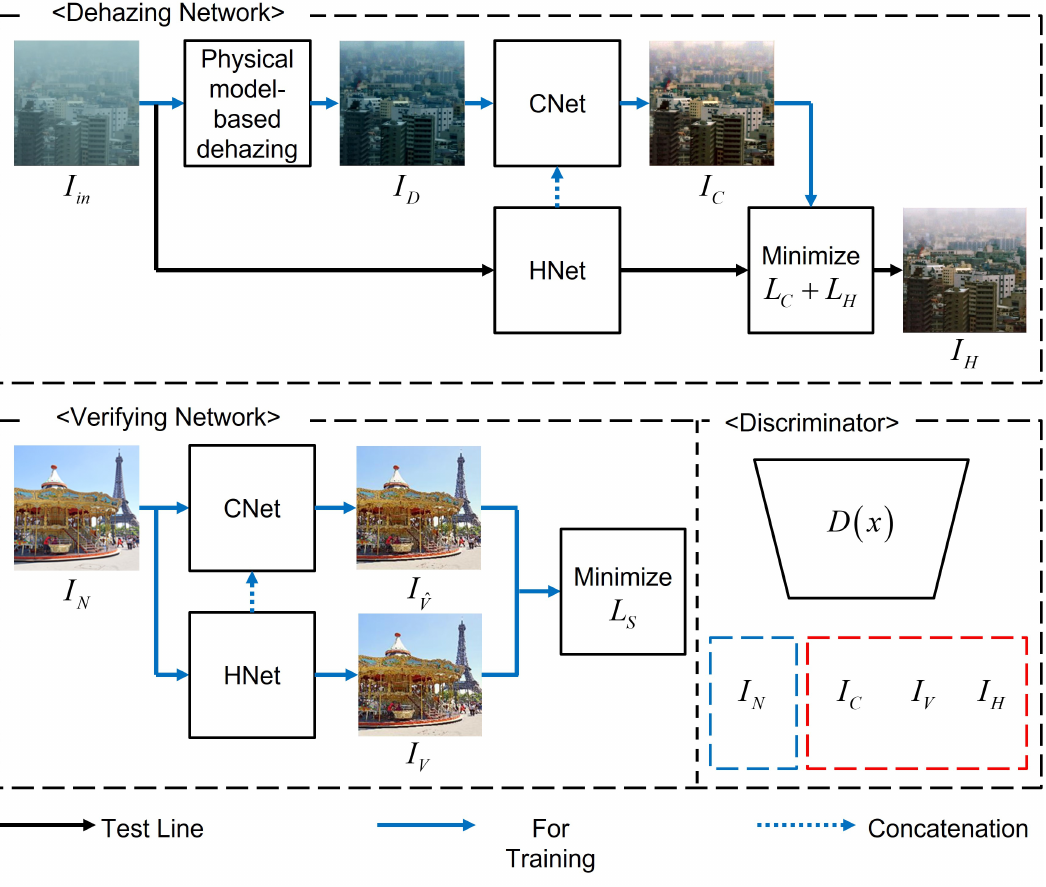
Figure 2. The architecture of the proposed DVNet. Note that the blue and black arrows are used for the training the DVNet. In the prediction procedure, only black arrows are efficiently